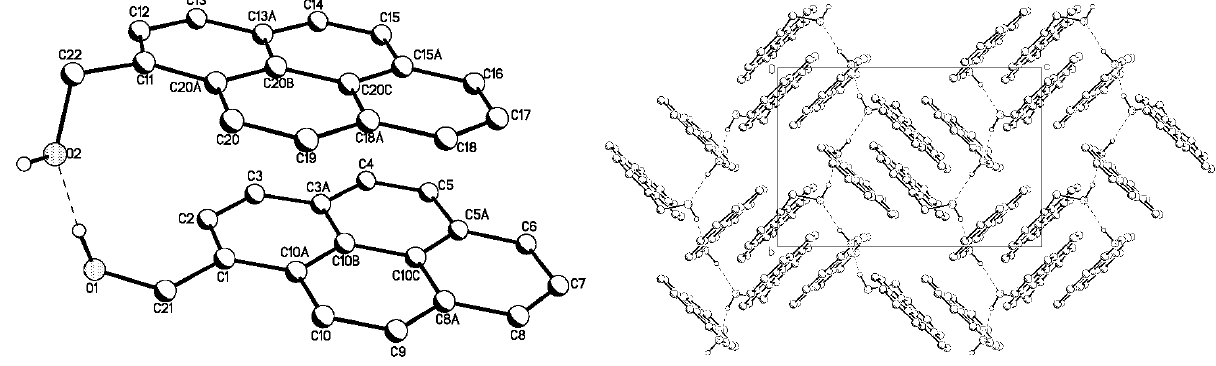
Figure 1. Crystal structure and crystal packing of the 1-(chloromethyl)pyrene 2 . Selected bond lengths [Å]: O(1)-C(21) = 1.421, C(21)-C(1) = 1.508, C(1)-C(2) = 1.378. Selected angles (°): O(1)-C(21)-C(1) = 114.2, C(21)-C(1)-C(2) = 120.2, C(1)-C(2)-C(3) =